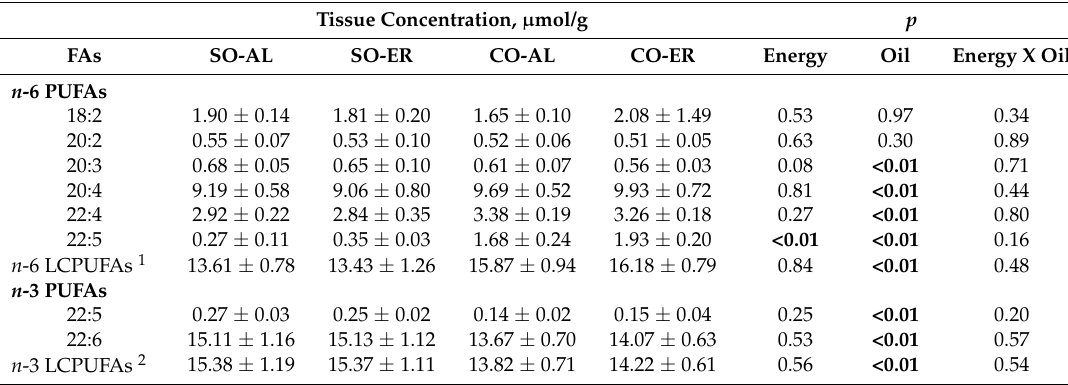
Table 4. PUFA concentration in the cerebellum of juvenile male rats.